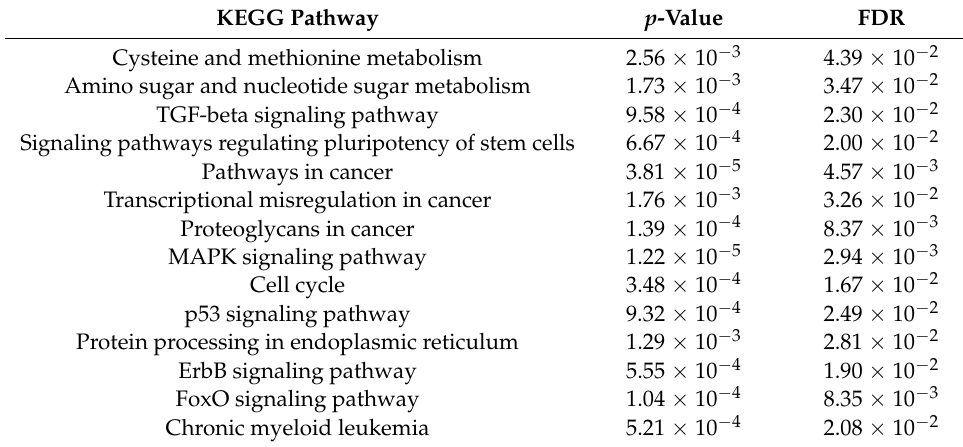
Table 3. Enriched KEGG pathways for target genes of 20 most abundantly expressed